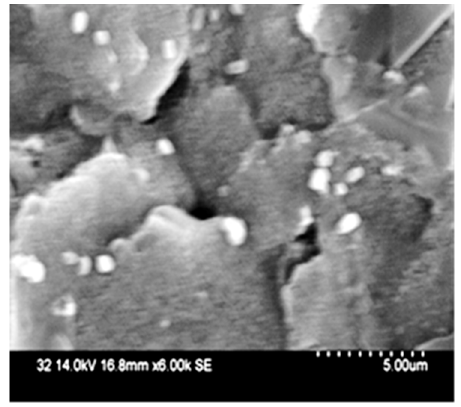
Figure 4. SEM image of AuNPs/SPC TTF E deposited at 0.18 V for 15 s.